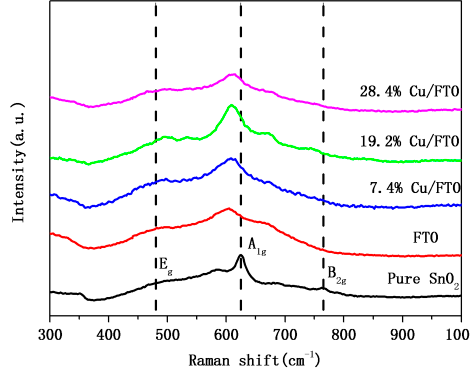
Figure 3. Raman spectra of pure SnO 2 , FTO and Cu/FTO samples.